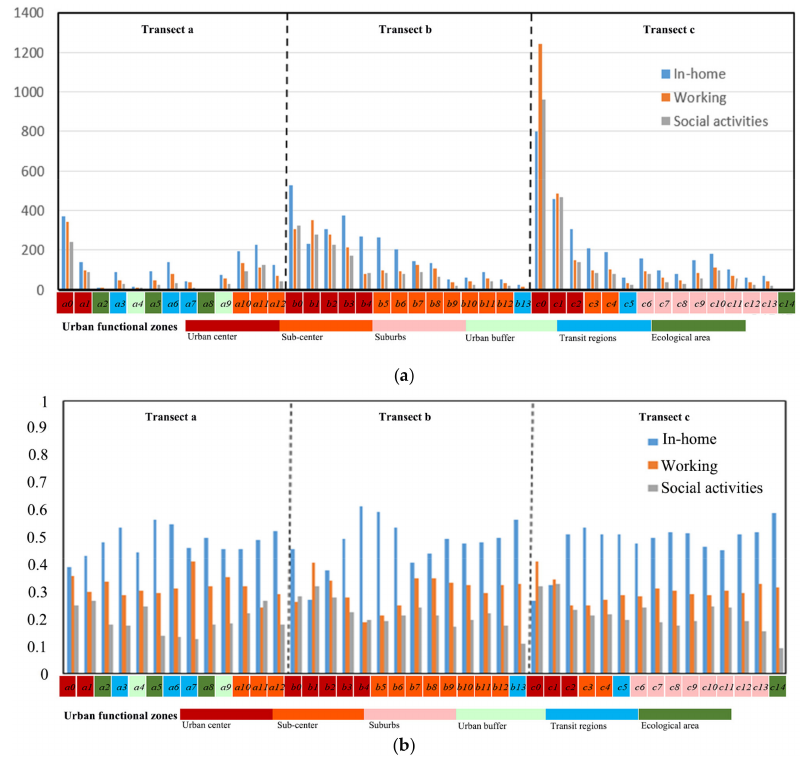
Figure 12. Spatial pattern of human activities along the urban gradient: ( a ) density; ( b )